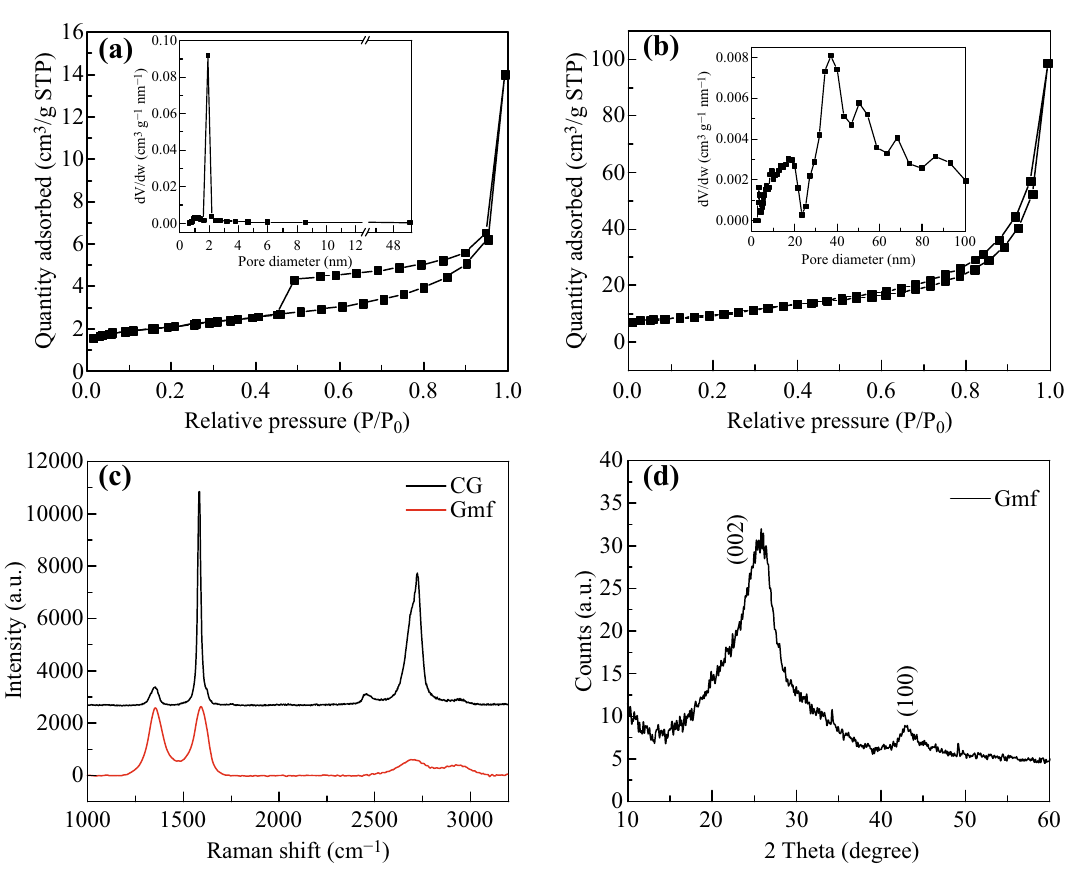
Fig. 2 a N 2 absorption/desorption curves of Gmfs. The insert is the calculated pore diameter distribution. b N 2 absorption/desorption curves of CG. The insert is the calculated pore diameter distribution. c Raman spectra of Gmfs and CG. d XRD pattern of